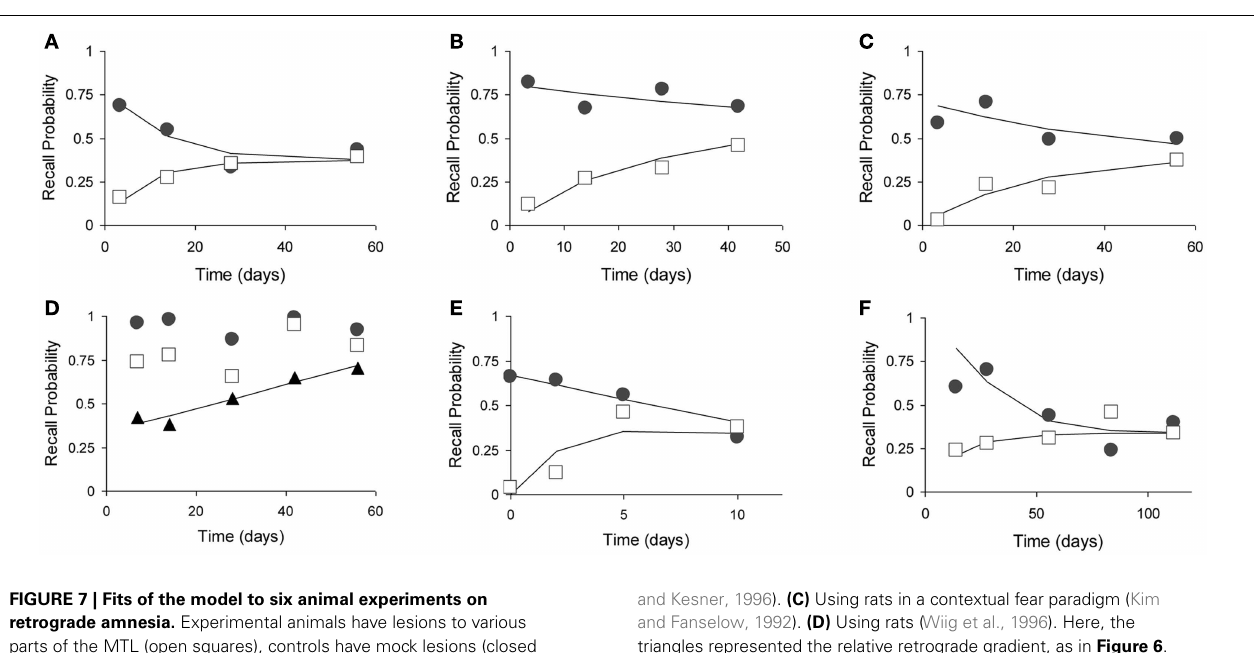
FIGURE 7 | Fits of the model to six animal experiments on retrograde amnesia. Experimental animals have lesions to various parts of the MTL (open squares), controls have mock lesions (closed circles). Fitted lines are solid without markers. See Table 2 for further details. (A) Using mice with two-choice spatial discrimination (Cho et al., 1993). (B) Using mice with two-choice spatial discrimination (Cho